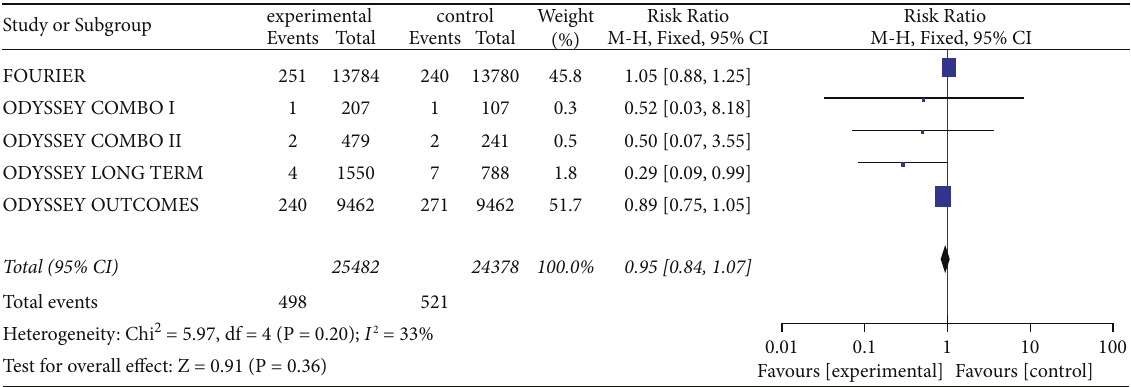
Figure 3: The cardiovascular mortality between two